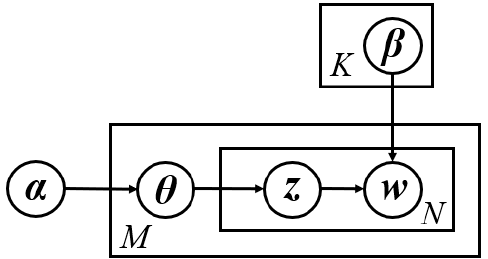
Figure 3. Graphical representation of the latent Dirichlet allocation (LDA) model. α , β and θ respectively represent the prior of Dirichlet distribution, the probability matrix and the parameter of multinomial distribution. z and w respectively represent the topics and visual words. M, N and K respectively represent the number of images, visual words and topics.